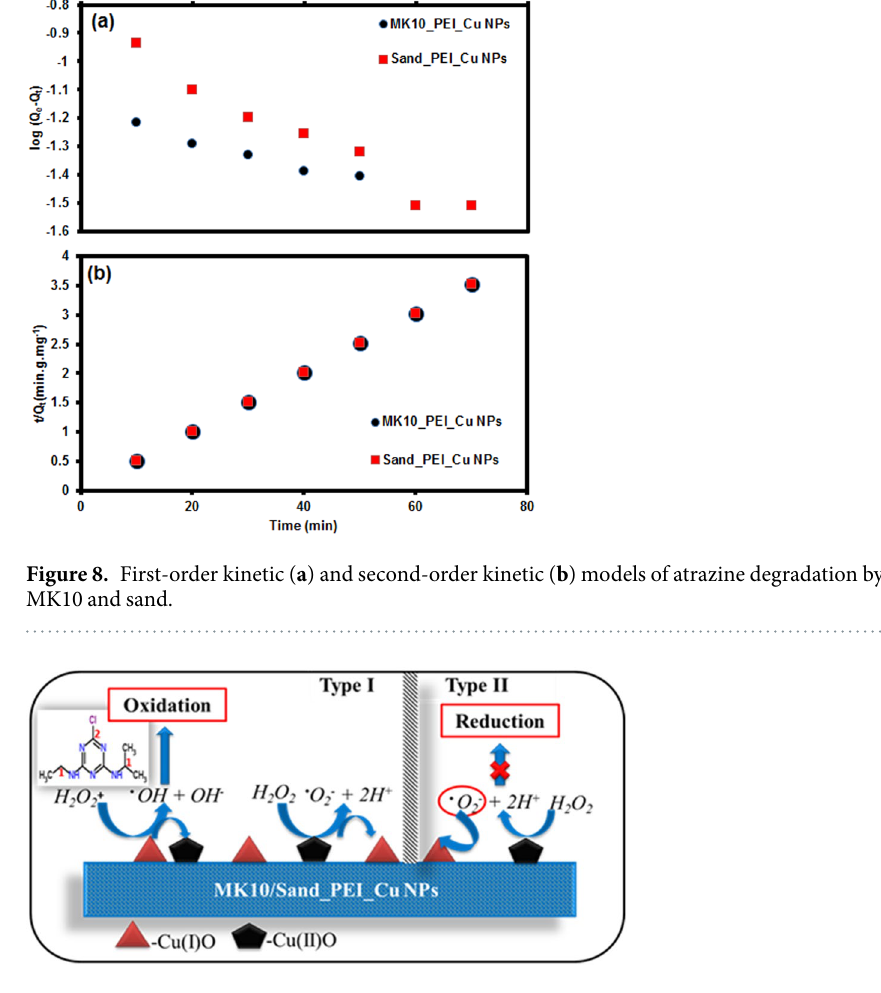
Figure 9. Schematic representation of possible